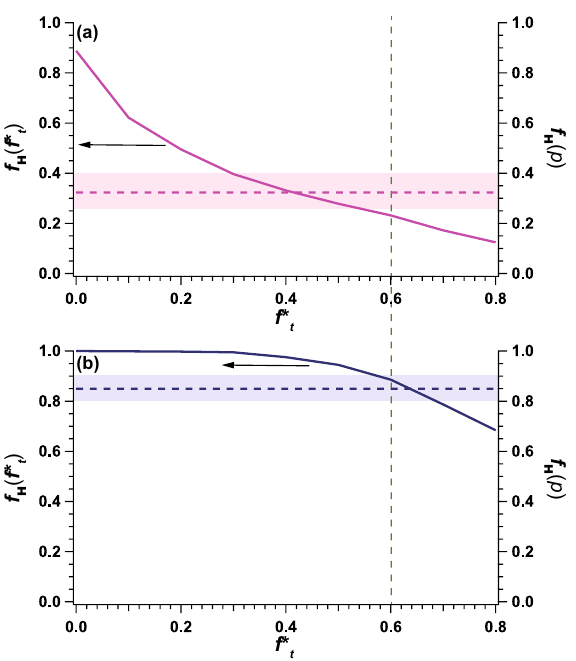
Figure 5. Fraction of surface H nex exposed to solvent ( r H ) as a function of factor for surface area of amino acid residues (= f* t ). Green dashed line, f* t = 0.6. (a) r H of MurD as a function of f* t (purple dotted line) (left axis). Pink dotted line, p value r H ( p ) of MurD (right axis). Pink shaded zone shows error of r H ( p ) of MurD. (b) r H of Hef-IDR as a function of f* t (blue dotted line) (left axis). Blue dotted line, r H ( p ) of Hef-IDR (right axis). Blue shaded zone shows error of r H ( p ) of Hef-IDR. This figure is prepared by the usage of IGOR Pro 6.34A (https